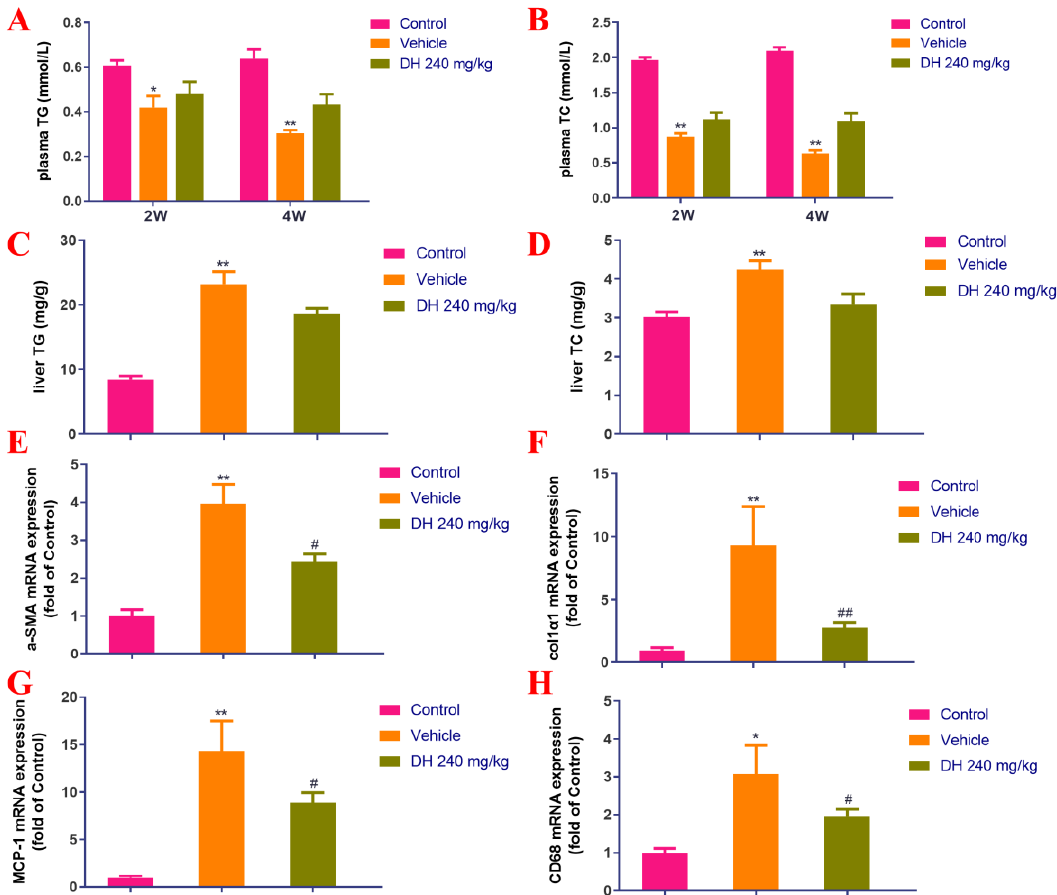
Figure 3. Effect of the ethyl acetate extract of D. heterophyllum supplementation on the blood serum levels of TC and TG, and the expression of related genes. Levels of TG ( A ), TC ( B ), liver levels of TG ( C ), and TC ( D ), col1α1 mRNA expression in the NASH mice. α -SMA mRNA expression ( E ), col1α1 mRNA expression ( F ), MCP-1 mRNA expression ( G ), and CD68 mRNA expression ( H ). DH 240 mg/kg: 240 mg/kg ethyl acetate extract. Values are presented as the mean ± SD ( n = 10). * p < 0.05, ** p < 0.01 vs. the control group; # p < 0.05, ## p < 0.01 vs. the vehicle group.